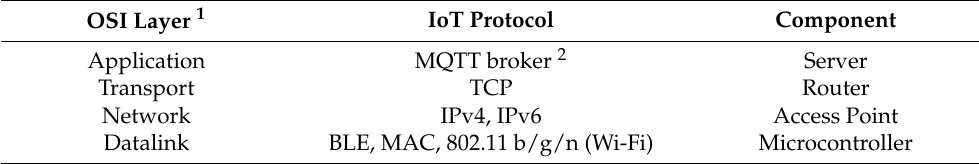
Table 5. Interconnection model and